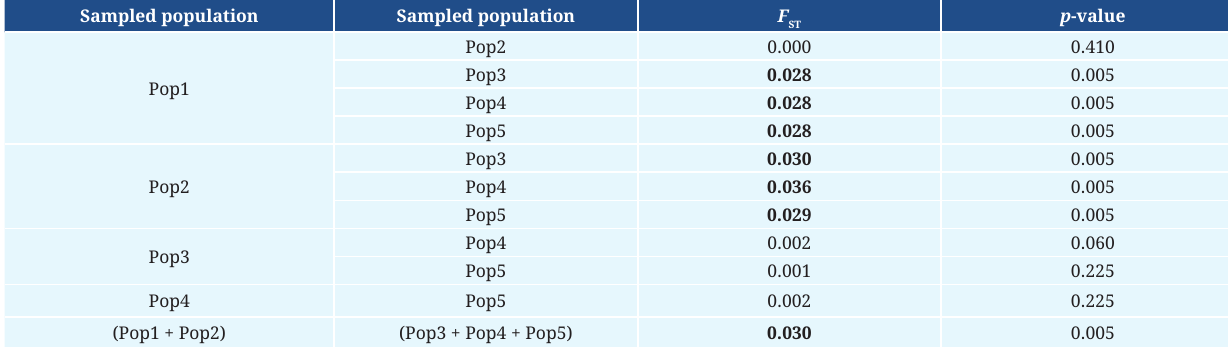
TABLE 2 | Pairwise genetic distance , F significant